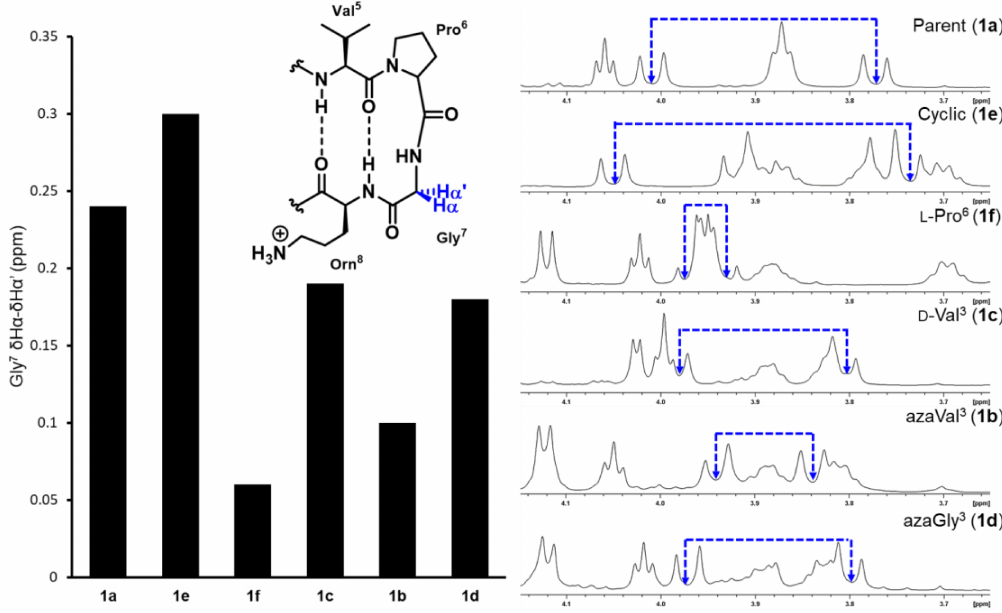
Figure 3. Diastereotopic splitting of Gly 7 H α chemical